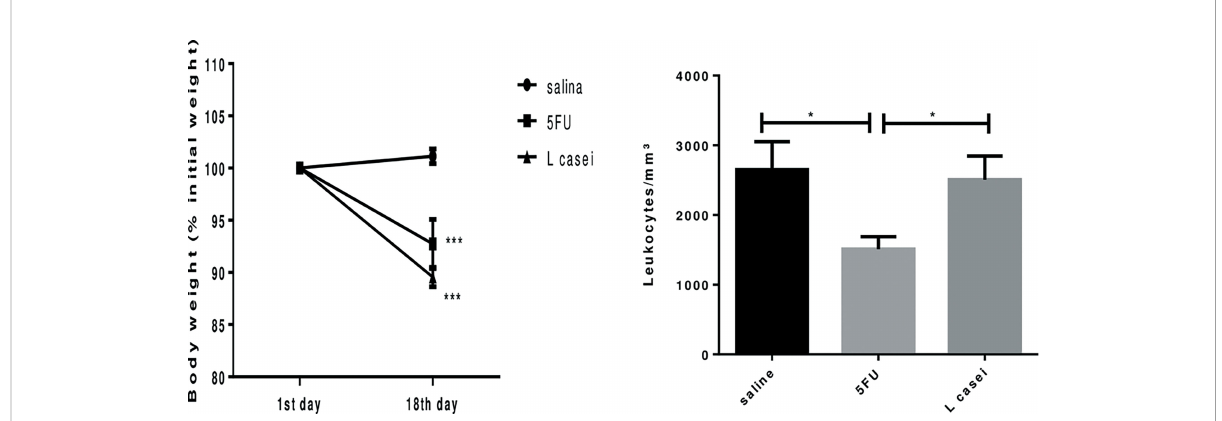
FIGURE 1 Weight of the animals (1 st day and 18 th day of treatment) and the leukocyte count (mm³) in the blood after euthanasia. Groups: Saline, 5FU (5- fl uorouracil) and L. Casei ( Lacticaseibacillus casei ). * p < 0.05, *** p <